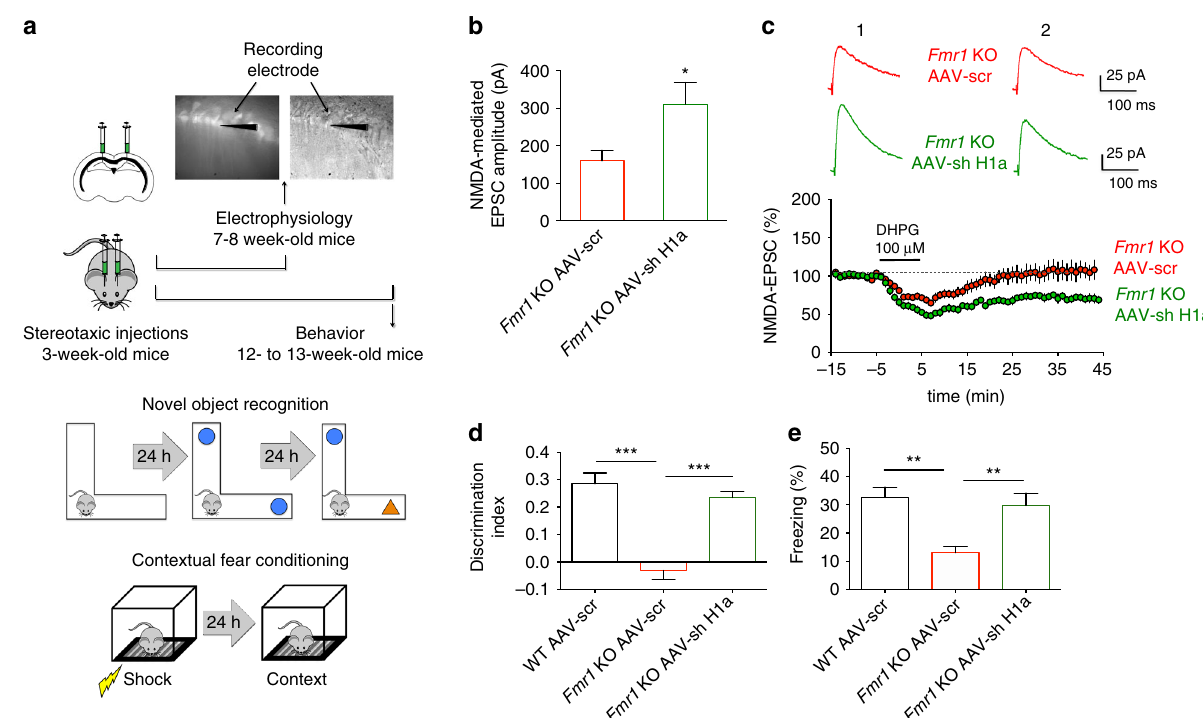
Fig. 6 Homer1a knockdown rescues synaptic NMDAR dysfunction and cognitive defects in Fmr1 KO mice. ( a ) Experimental procedure: electrophysiology (upper panel), novel object-recognition task (NOR) on L-maze (middle panel), contextual fear-conditioning task (CFC) (lower panel). WT and Fmr1 KO mice (21 days) were bilaterally injected into the dorsal hippocampus with AAV-shH1a or AAV-Scr expressing GFP, and tested at 7 – 8 weeks (electrophysiology; b , c ) or 12 – 13 weeks of age (behavior; d , e ). ( b ) The EPSC NMDA amplitude of Fmr1 KO AAV-sh H1a mice (311.3 ± 58 pA) was larger than that of Fmr1 KO AAV-scr mice (160.4 ± 27.8 pA, n = 12 neurons from 4 animals for both conditions, * P < 0.05, t = 2.35, df = 22, unpaired Student ’ s t -test). ( c ) AAV-sh H1a infection in Fmr1 KO mice rescues LTD of EPSC NMDA induced by DHPG (100 µ M, 10 min) (EPSC NMDA amplitude 40 min after